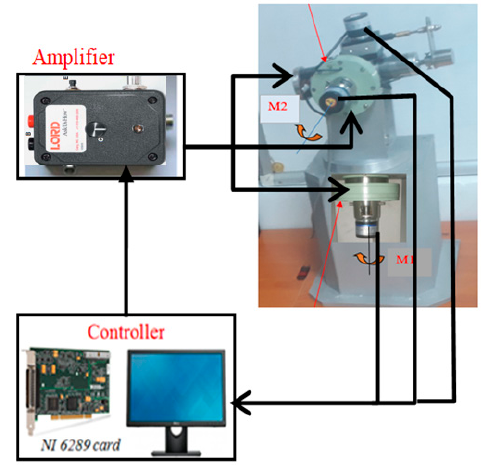
Figure 21. Experimental setup of the 3-DOF spherical force feedback system.